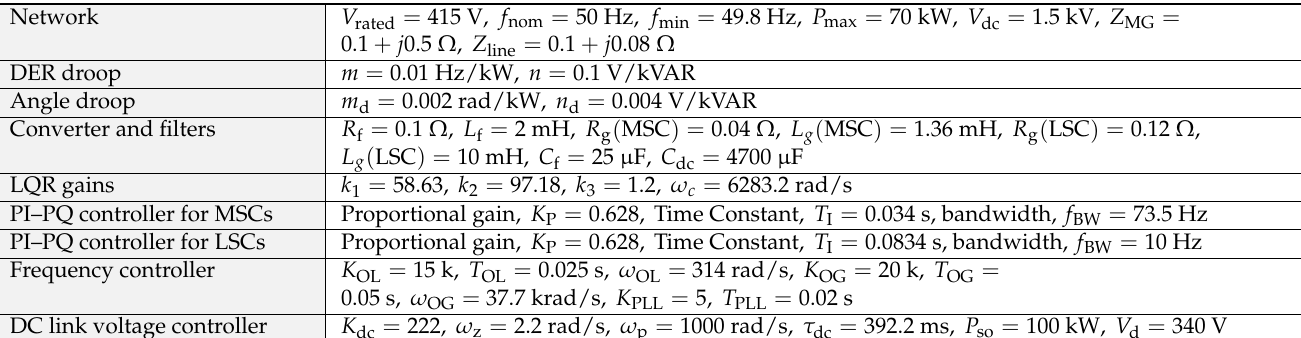
Table A1. Technical data of network under